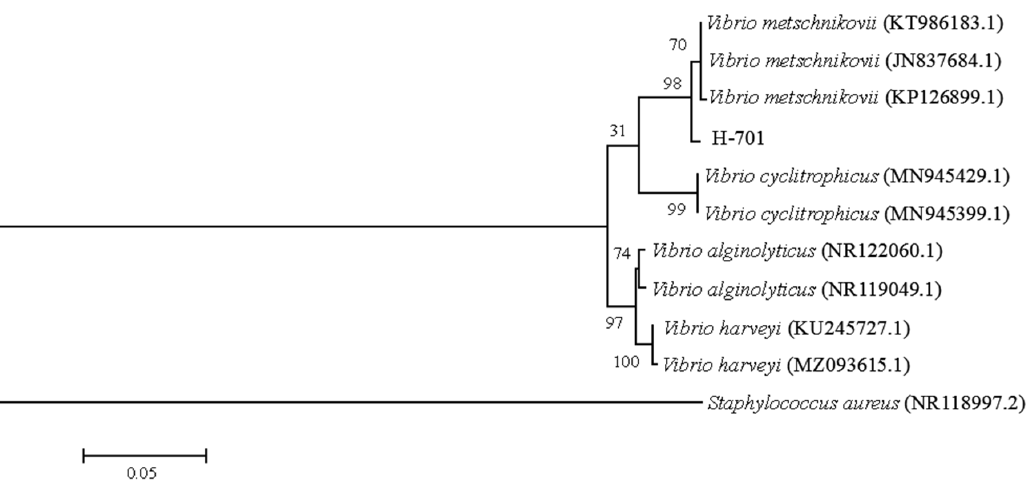
Figure 3. Phylogenetic tree of strain H-701 based on 16S rRNA gene sequences. The values at the node indicate the percentage of trees in which this grouping occurred after bootstrapping the data (1000 replicates). The scale bar indicates the number of substitutions per site.